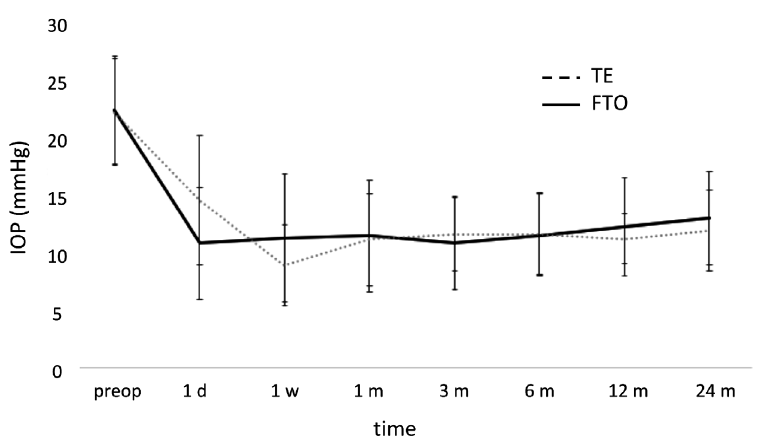
Figure 3. Mean preoperative vs postoperative intraocular pressure (IOP) of filtering trabeculotomy (FTO) and trabeculectomy (TE) (mean±SD).